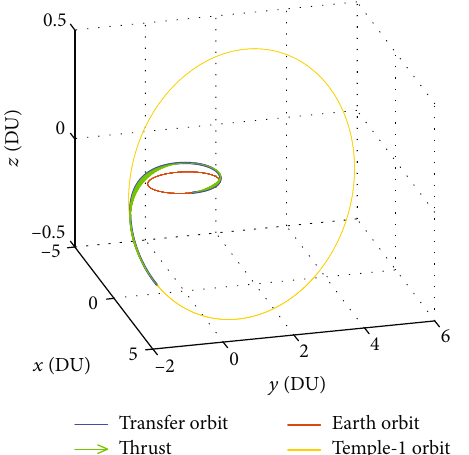
Figure 11: Optimal transfer trajectory of Tempel-1 mission.